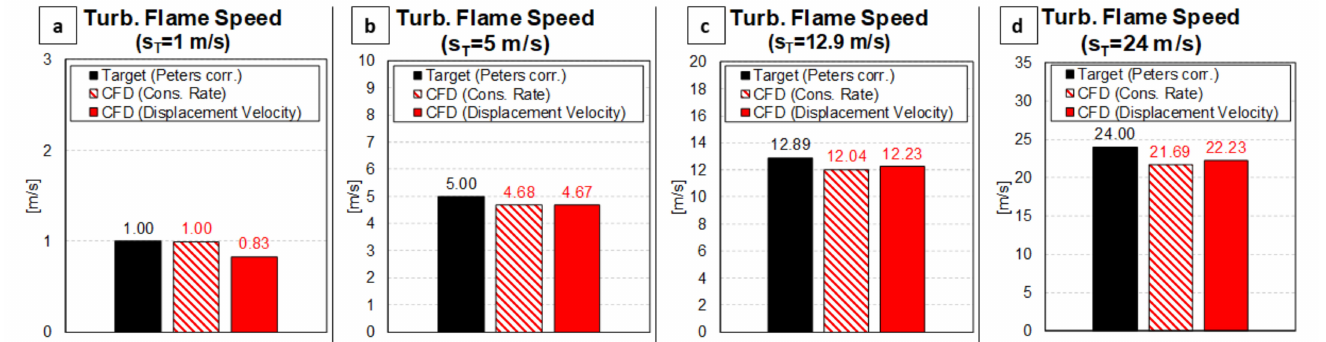
Figure A1. Simulated turbulent flame speed s T calculated from flame displacement velocity (solid red bars) and from the rate of production of products (dashed red bars), compared with the theoretical prediction from Peters correlation (black bars): s T = 1 m/s ( a ), s T = 5 m/s ( b ), s T = 12.9 m/s ( c ), and s T = 24 m/s ( d ).